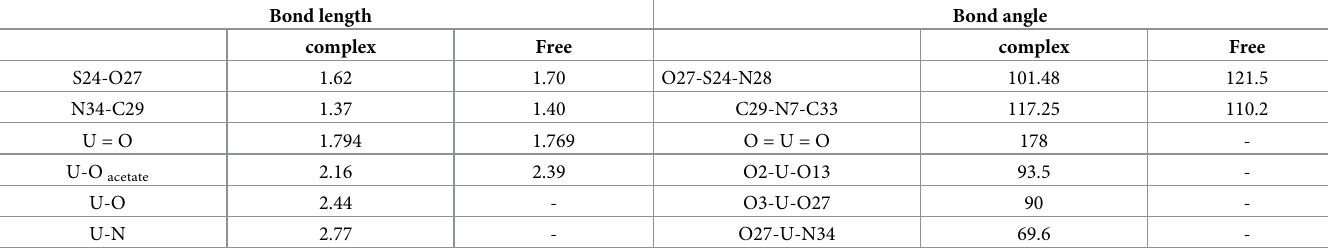
Table 5. Geometric ( Å , deg) comparison of free ligand/ uranyl acetate and calculated structures for [(UO 2 )(OAc) 2